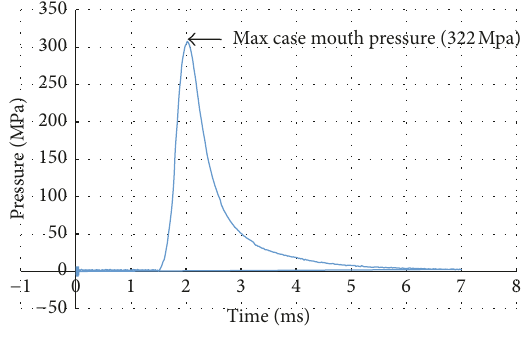
Figure 10: Pressure-time